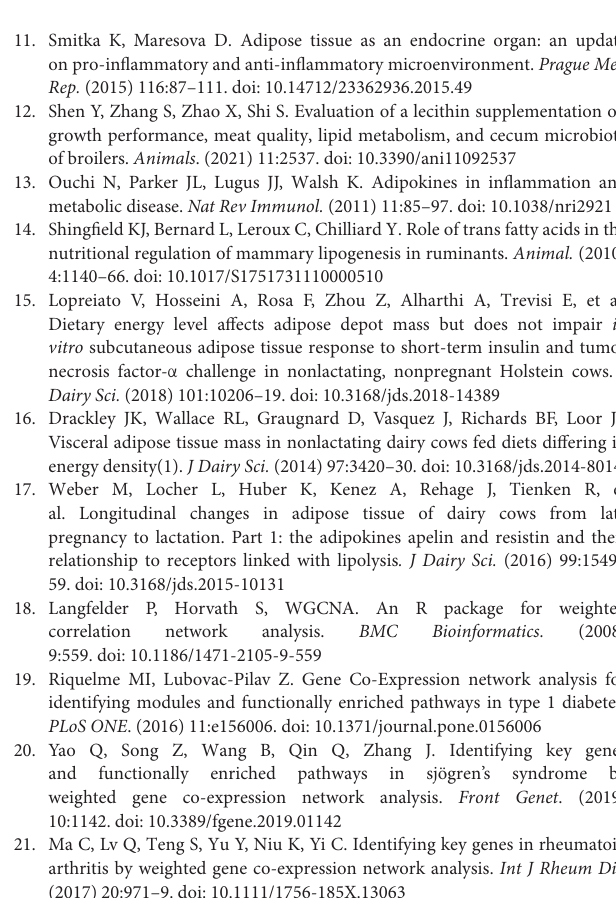
Supplementary Figure 6 | Gene set variation analysis (GSVA) results in subcutaneous (A) and visceral (B) adipose tissues. Supplementary Figure 7 | Gene set enrichment analysis (GSEA) results in subcutaneous adipose tissue (A) , and visceral adipose tissue (B) . The horizontal axis represents the ranked gene list according to the log2 FC values between high and low nutrition groups. The vertical axis represents enrichment scores (upper) and the log2 FC values (lower). Each color represents a pathway marked in the upper right corner. Supplementary Figure 8 | Circos plot to indicate the relationship between hub genes and KEGG pathways. Supplementary Figure 9 | Expression analysis of marker genes of fat metabolism in subcutaneous (A) and visceral (B) adipose tissues. Supplementary Table 1 | Experimental and phenotypical information of the used datasets (PRJNA382633 and PRJNA664093). Supplementary Table 2 | Modules and genes identified in subcutaneous adipose tissue (PRJNA382633) and visceral adipose tissue (PRJNA664093). Supplementary Table 3 | Single-gene gene set enrichment analysis (GSEA) results in hub genes in subcutaneous adipose tissue. Supplementary Table 4 | Single-gene GSEA results in hub genes in visceral adipose tissue. Supplementary Table 5 | Gene set enrichment analysis results in subcutaneous and visceral adipose